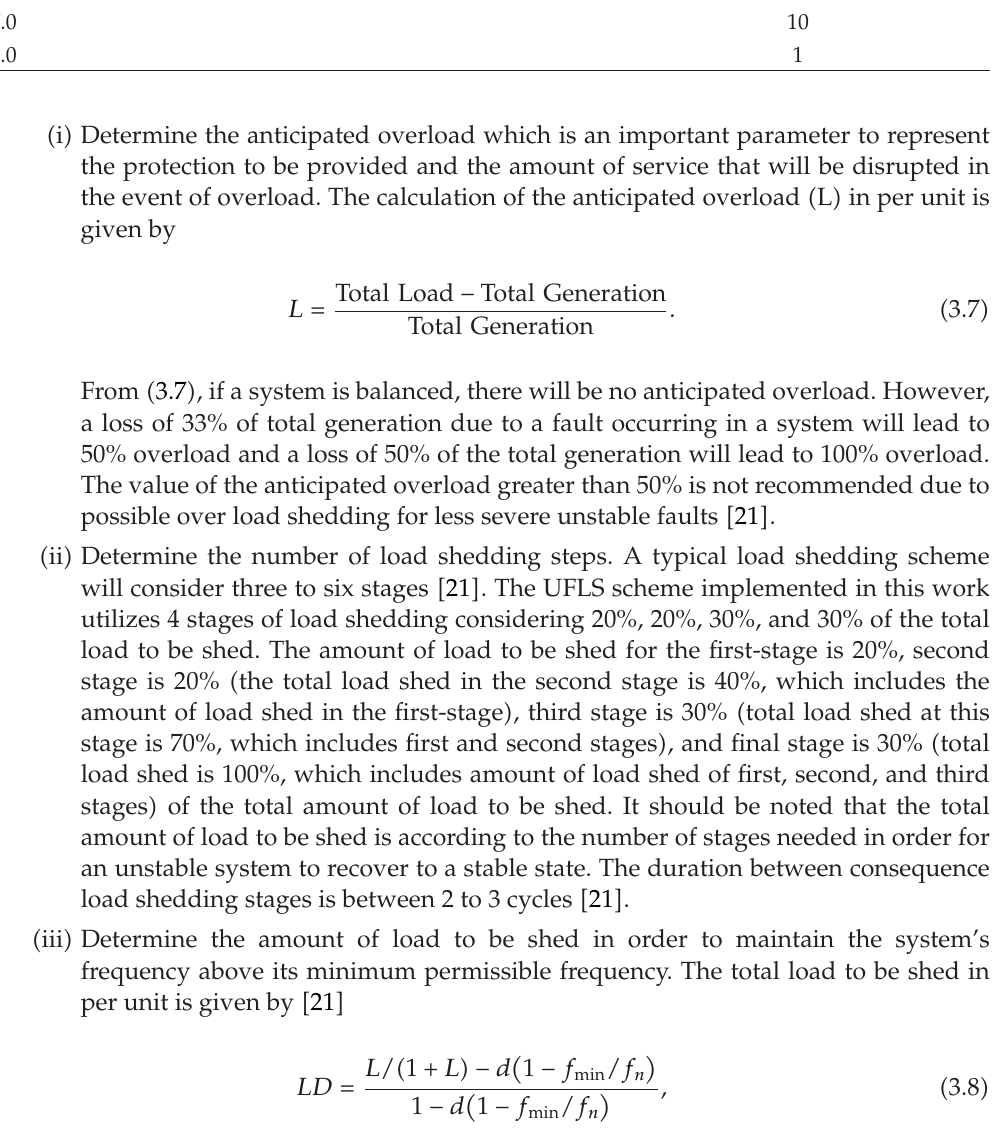
Table 1: Typical time limits for the operation of generators at frequencies below their rated frequency. Percentage of rated frequency at full load (cid:5) % (cid:6) Maximum permissible time (cid:5) minutes (cid:6) 99.0 Continuous 97.3